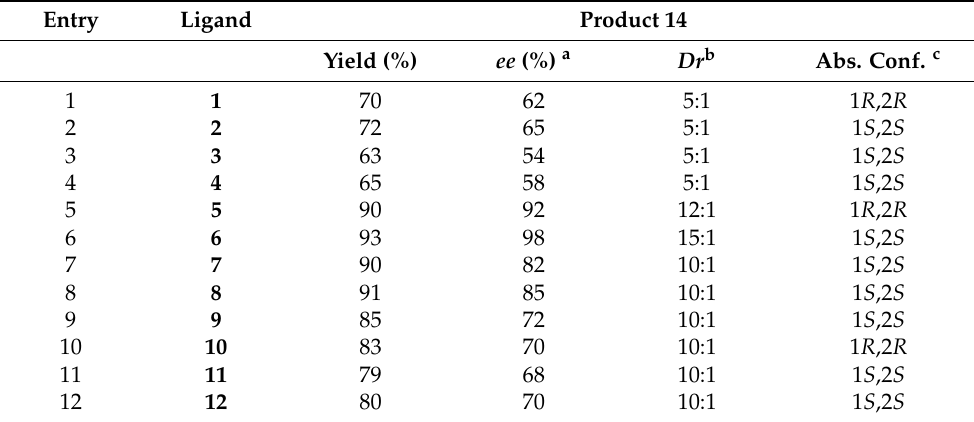
Table 1. Asymmetric Simmons–Smith cyclopropanation of cinnamyl alcohol catalyzed by aziridines